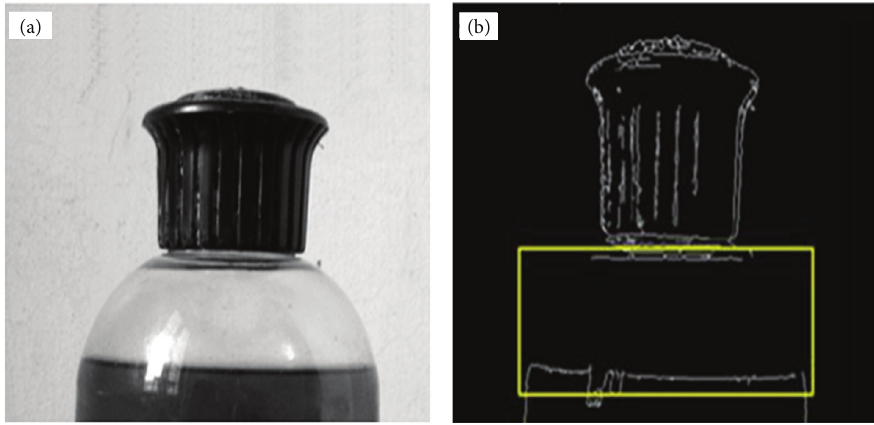
Figure 3: (a) Bottle of liquid. (b) Detection of surface level of liquid in